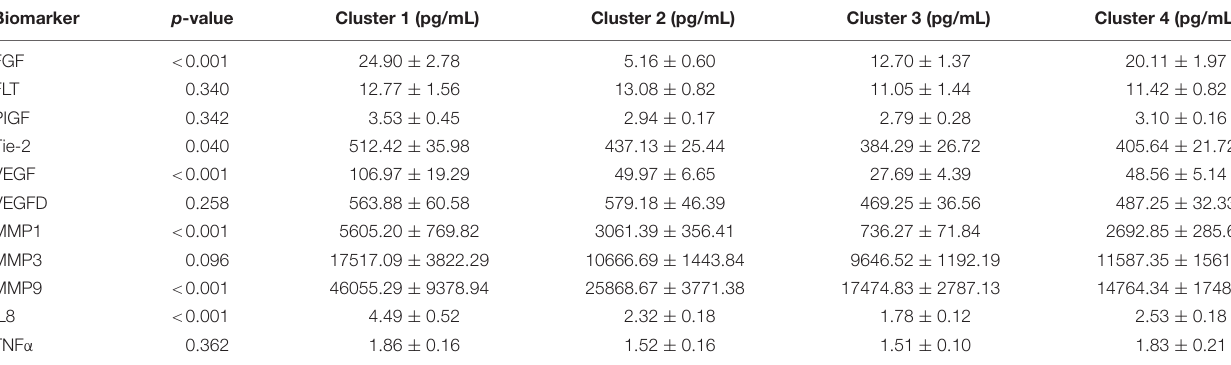
TABLE 3 | Means ± SEM for clusters 1–4 produced by the Euclidean distance